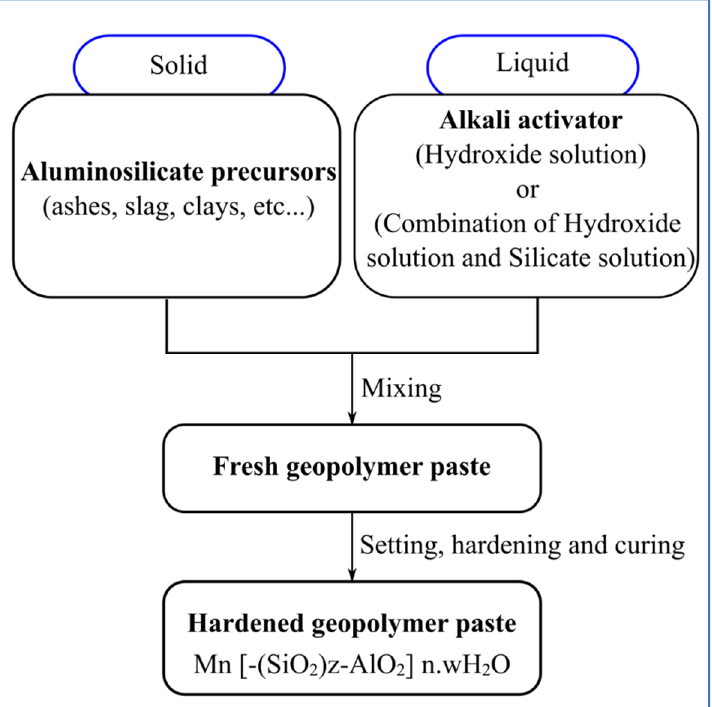
Figure 1. Illustration of Geopolymer Synthesis [47].